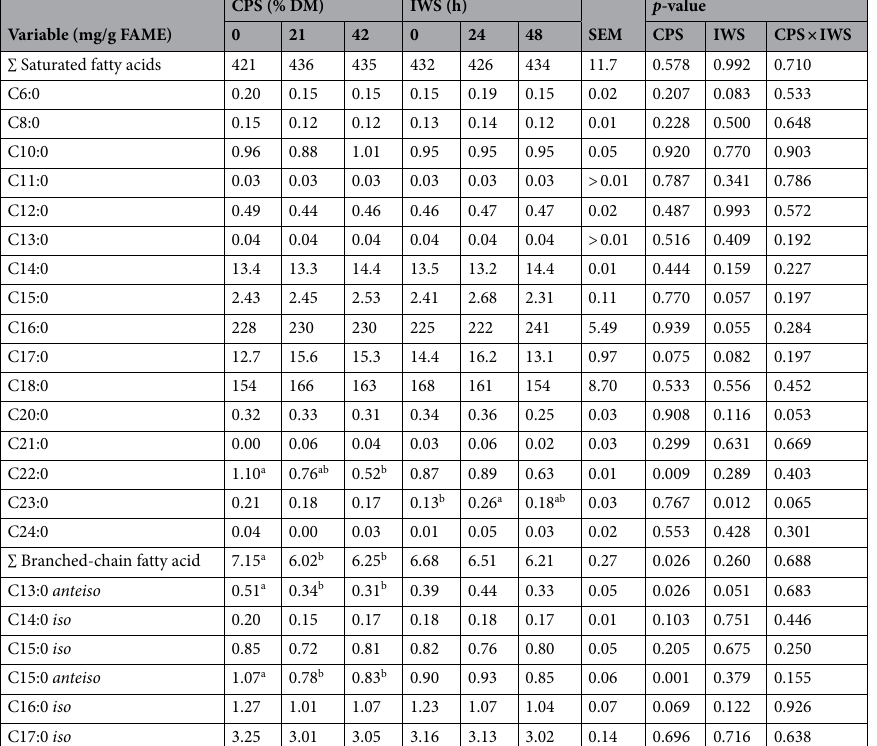
Table 6. Fatty acid from L. lumborum muscle of goats fed with cactus pear silage (CPS) and submitted to intermittent water supply (IWS). a,b Means within rows with different letter superscripts differ by Tukey test ( p < 0.05).